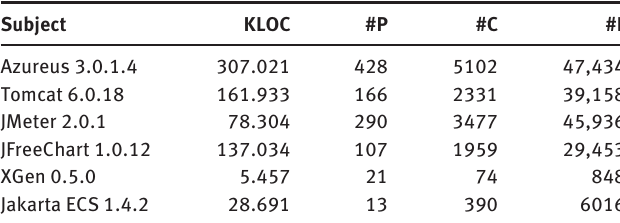
Table 1. Size Characteristics of the Examined Software